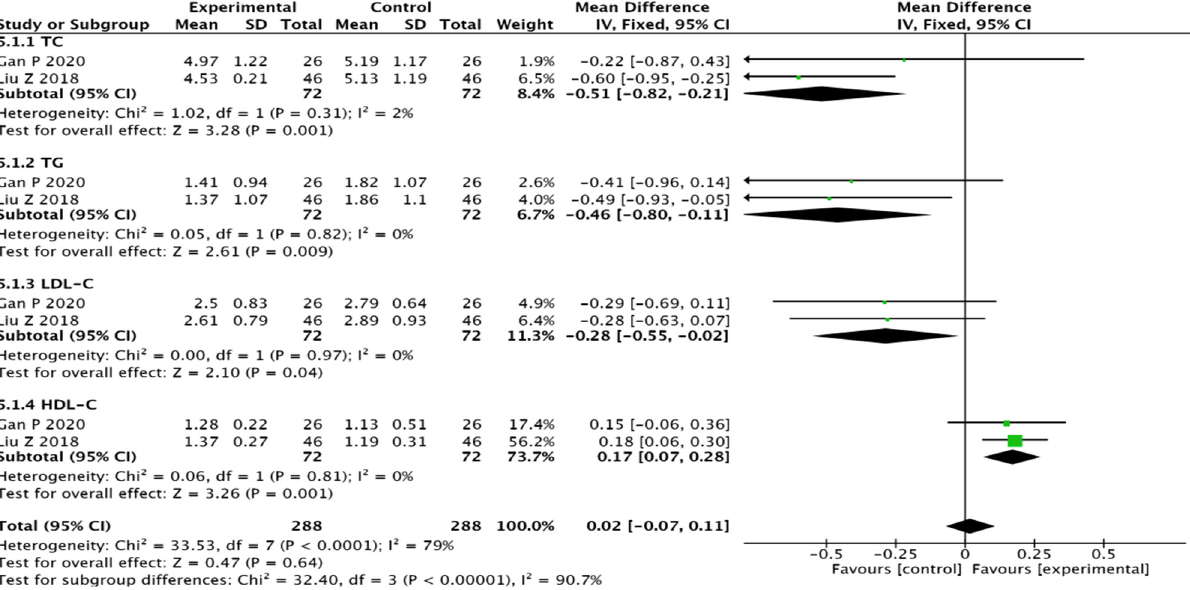
Figure 10. Forest plot of adverse reactions. 3.4. Publication Bias The MMSE (Figure 11a) and MoCA (Figure 11b) scales present significant asymmetry in the funnel plots, indicating the presence of publication bias in the included studies, possibly due to the small number of included studies and the difficulty of including neg- ative results. Other outcome indicators were challenging to plot due to the insufficient number of studies presenting insufficient test validity scores.